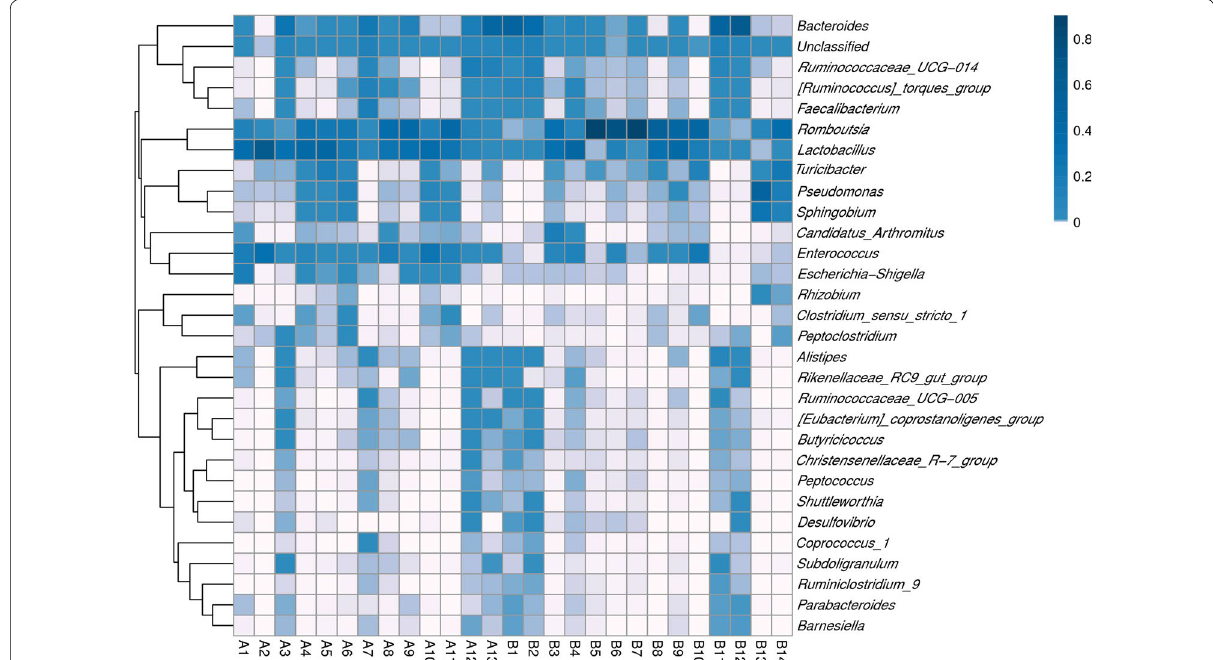
Fig. 5 Heat map analysis of the 27 samples. Heat map showing the abundances of the top 30 genera were clustered and plotted using R software. Blue represents genera with higher abundances in the corresponding sample, and white represents genera with lower abundances